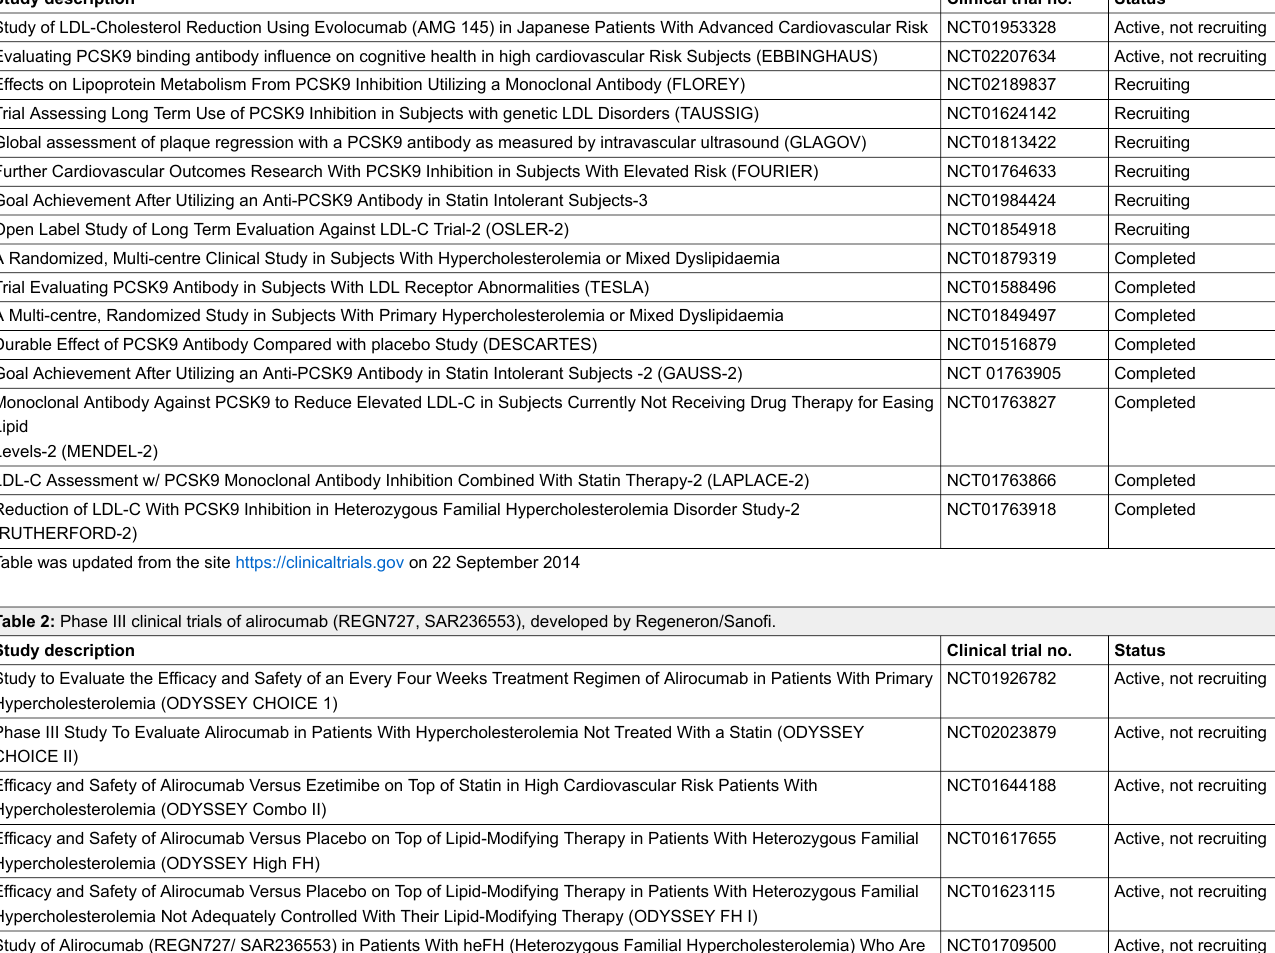
Table 1: Phase III clinical trials of evolocumab (AMG 145), developed by Amgen.